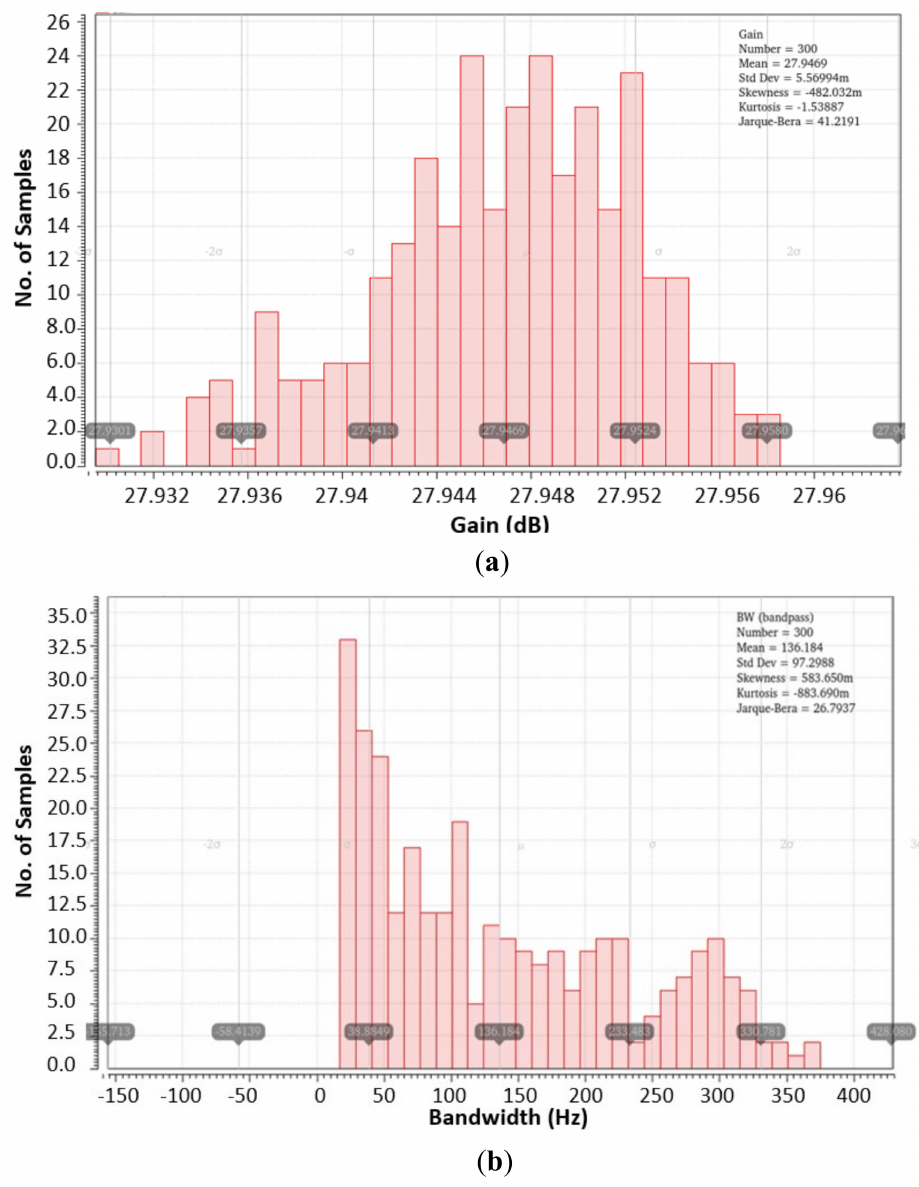
Figure 8. Monte-Carlo simulation for the proposed 3T-BCL topology; ( a ) gain, dB ( b ) bandwidth,